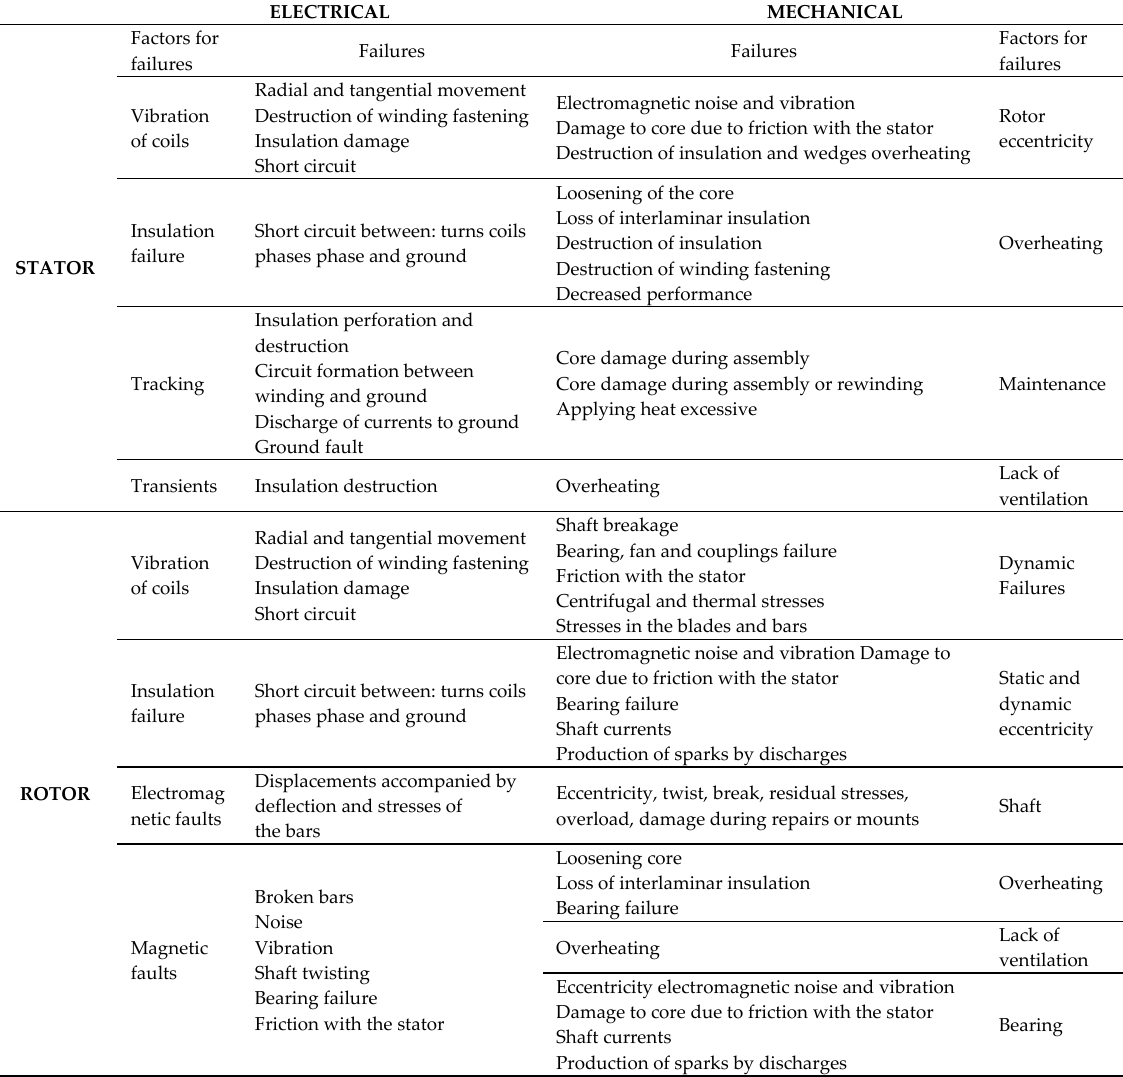
Table 2. Mechanical and electrical failures according to the parts of the